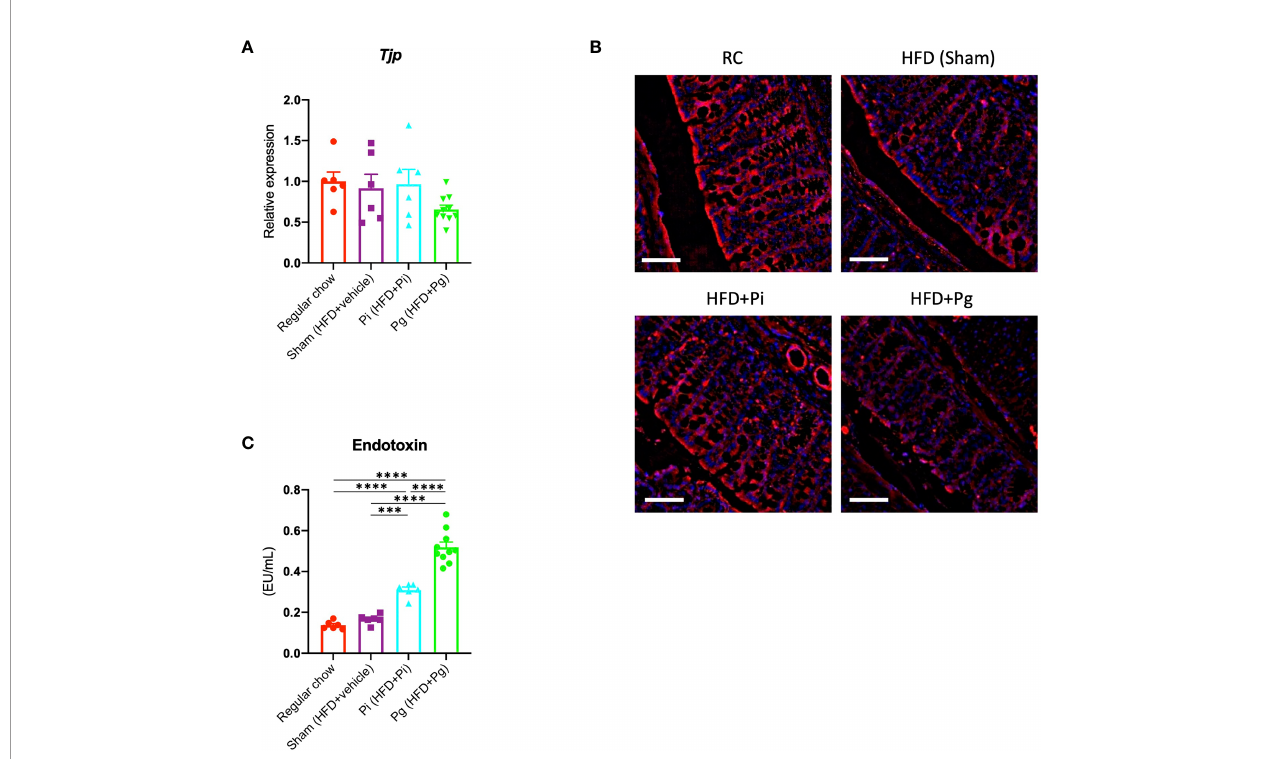
FIGURE 3 | P. gingivalis administration induces gut barrier dysfunction. (A) Expression of Tjp1 in the small intestines. cDNA was ampli fi ed with primers speci fi c for Tjp1 (n=6-10/group). The relative quantity of mRNA was normalized to that of glyceraldehyde-3-phosphate dehydrogenase mRNA. (B) Immuno fl uorescence analysis of E-cadherin in large intestines from each group. Red: E-cadherin, blue: DAPI, scale bars: 50 m m. (C) Serum endotoxin levels in the various groups (n=6-10/group). Data are expressed as the mean ± standard error of the mean (SEM). P values were calculated using one-way ANOVA with Tukey ’ s multiple comparisons test. *** P <0.001, **** P